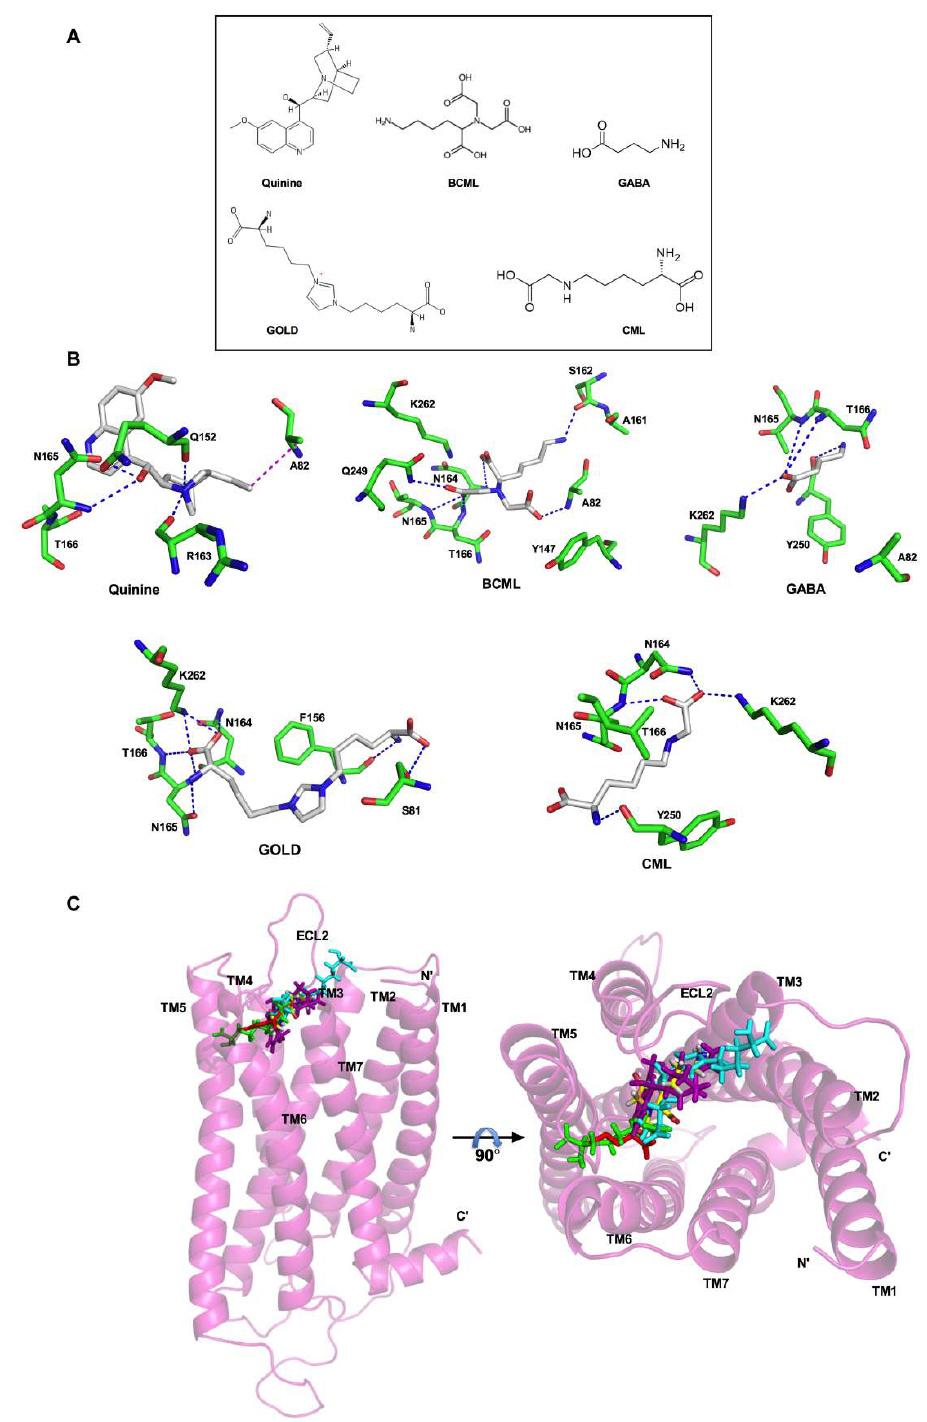
Figure 2. Model of T2R4 bound to GOLD and CML, and a comparison of their binding modes. ( A ) 2D structures of Quinine, BCML, GABA, GOLD, and CML. ( B ) 3D representation of the predicted interactions (dashes) of Quinine, BCML, GABA, GOLD, and CML with the residues (sticks) in the binding pocket of T2R4. The essential interactions with T2R4 are conserved in all the ligands. In contrast to BCML, GOLD and CML show interactions with K262 and not with A82, which is similar to GABA interactions. ( C ) The side view and top view of the superimposed homology models of T2R4 docked with CML (green), GOLD (cyan), BCML (yellow), GABA (red), and Quinine (magenta). The extracellular loop 2 (ECL2) of T2R4 is in close proximity to the docked compounds. TM: transmembrane helix.